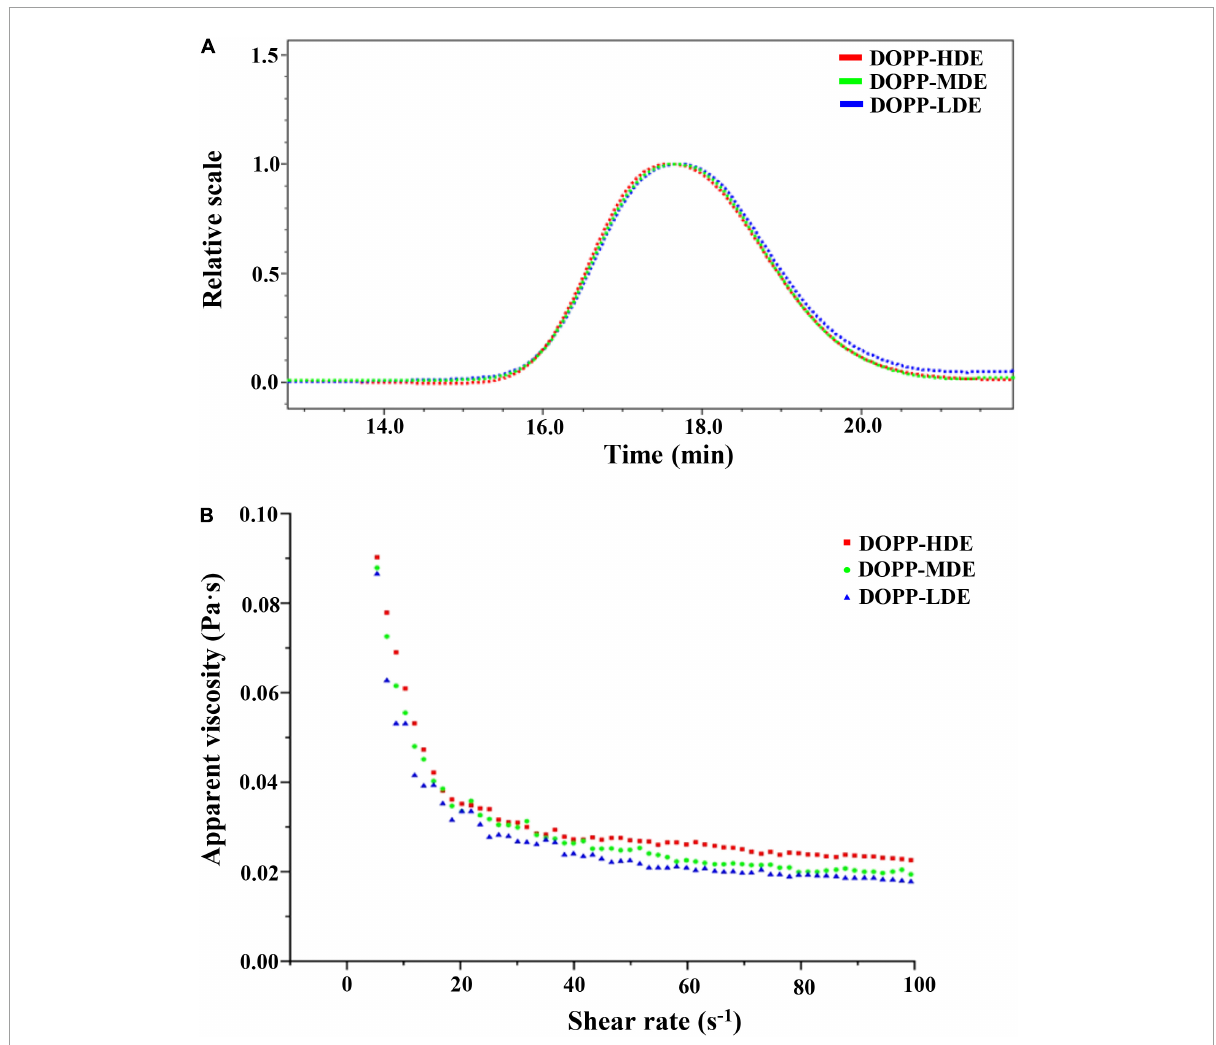
FIGURE3 Size exclusion chromatograms (A) and dependences of apparent viscosity on the shear rate (B) of okra pectic-polysaccharides (OPP) with various degrees of esterification. The sample codes were the same in Figure 1